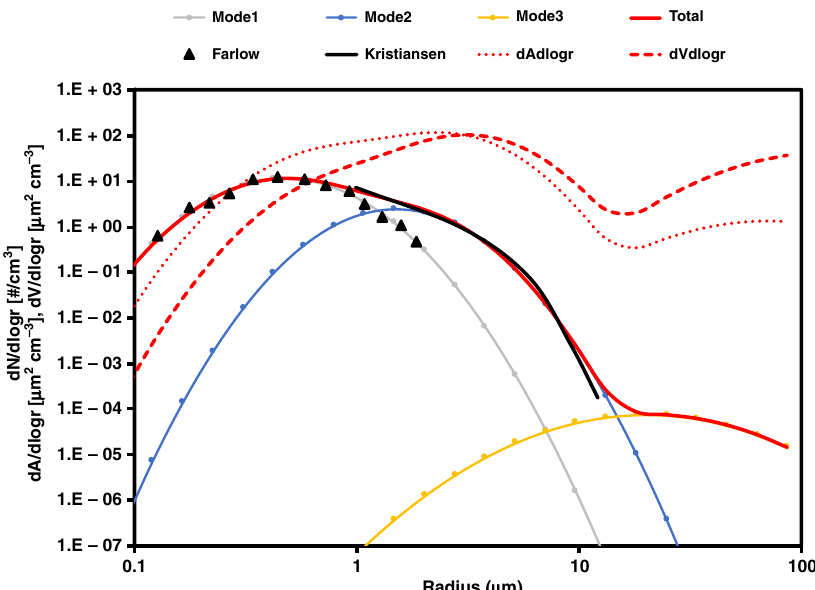
Fig. 8 The initial size distribution of ash. The gray line represents mode 1 and fi ts the black triangles by Farlow et al. 7 . The blue line represents mode 2 and fi ts the black line by Kristiansen et al. 54 . The yellow line represents mode 3 based on Durant et al. 8 . The red solid line is the sum of the three modes and is the number size distribution used for initial injection of ash. We also show a red dotted line and a red dash line representing the area size distribution and volume size distribution for the initial ash